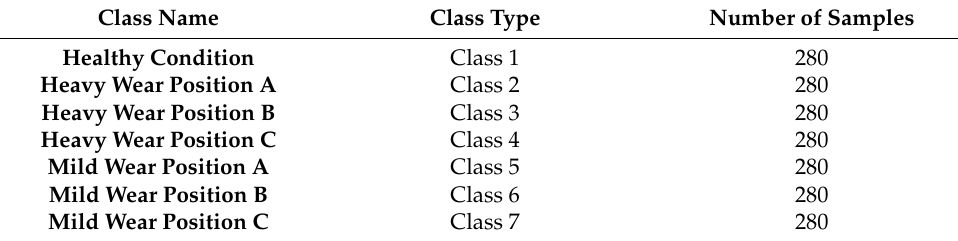
Table 1. Stamping tool condition data set.